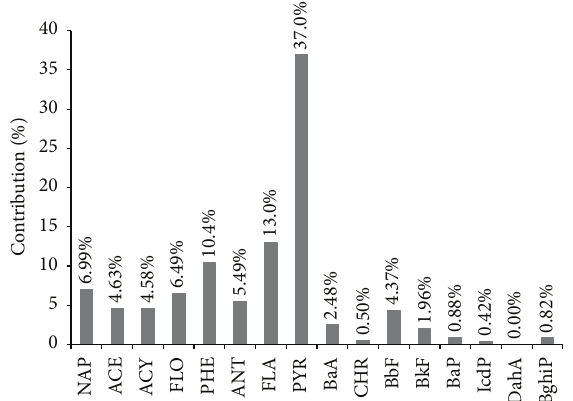
Figure 2: Relative contribution of individual PAH to PAH16 in the vegetables.